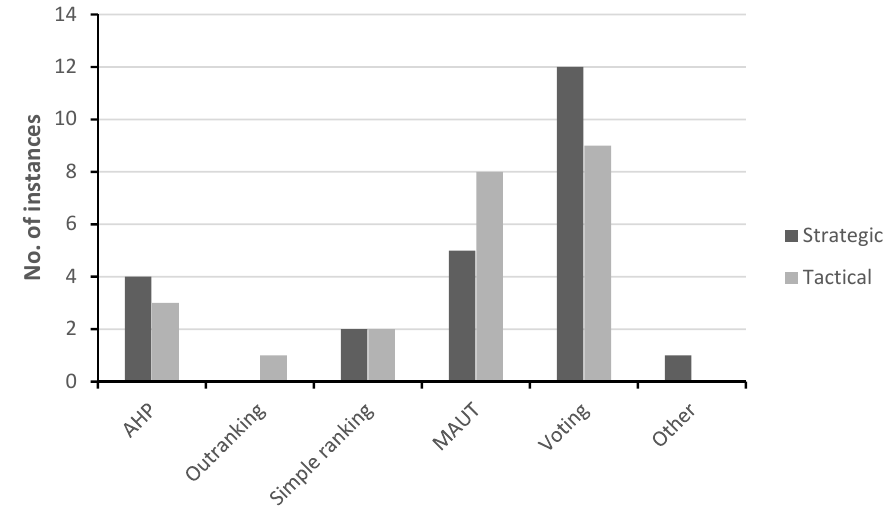
Figure 3. The use of MCDA methods for strategic and tactical problems.